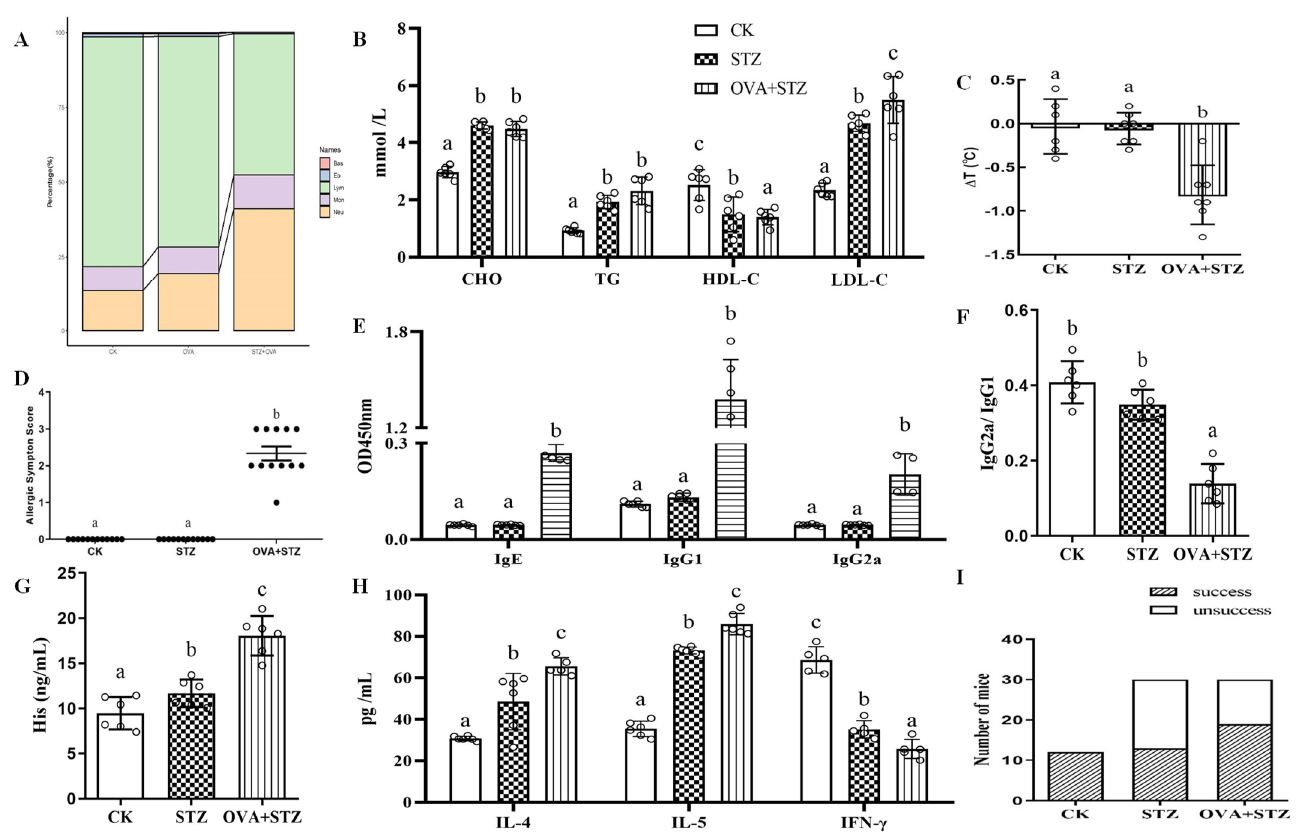
Figure 4. Effects of food allergy on diabetes. ( A ), The proportion of leucocyte (Lymphocytes, mono- cytes, and granulocytes) component distribution. Orange, purple, green, blue, and red represented neutrophile, monocyte, lymphocyte, eosinophils, and basophilic, respectively. ( B ), Serum levels of CHO, TG, HDL-c, and LDL-c. ( C ), Rectal temperature change. ( D ), Food allergy symptom score. ( E ), Serum-specific antibody levels of IgE, IgG1, and IgG2a. ( F ), Serum specific antibody IgG2a/IgG1 level. ( G ), Histamine levels. ( H ), Cytokines levels of IL-4, IL-5, and IFN-γ. The error bars indicated the mean ± SEM. n = 6. Different lowercase letters in the figure represent significant differences between the groups ( p < 0.05 by one-way ANOVA followed by SNK). ( I ), The success rate of animal experimental models (by the chi-square analyses).